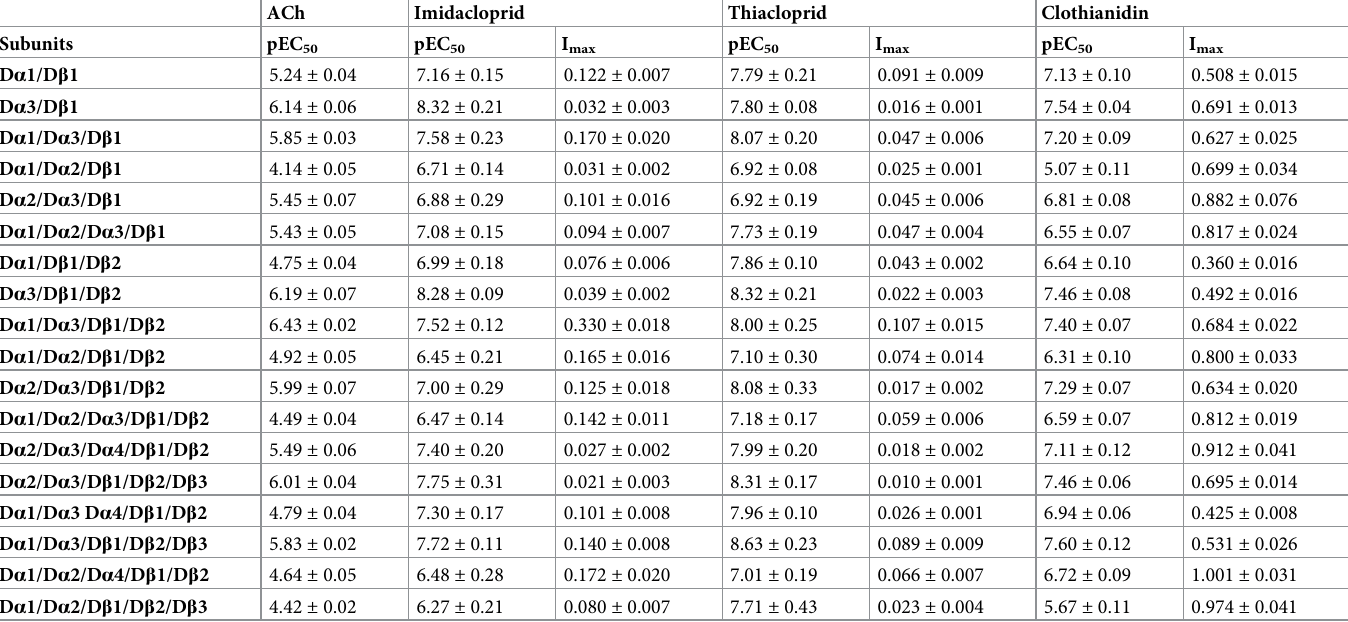
Table 1. Agonist actions of ACh and neonicotinoids on D . melanogaster nAChRs expressed in X . laevis oocytes �